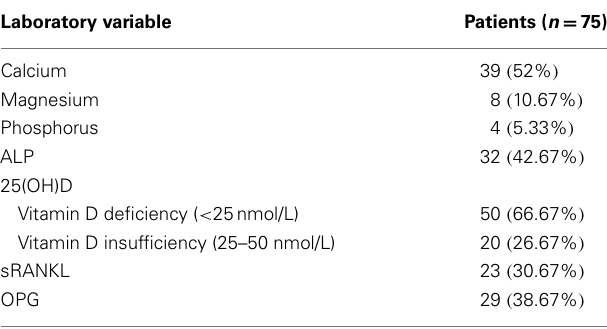
Table 5 |The frequency of patients with abnormal biochemical parameters